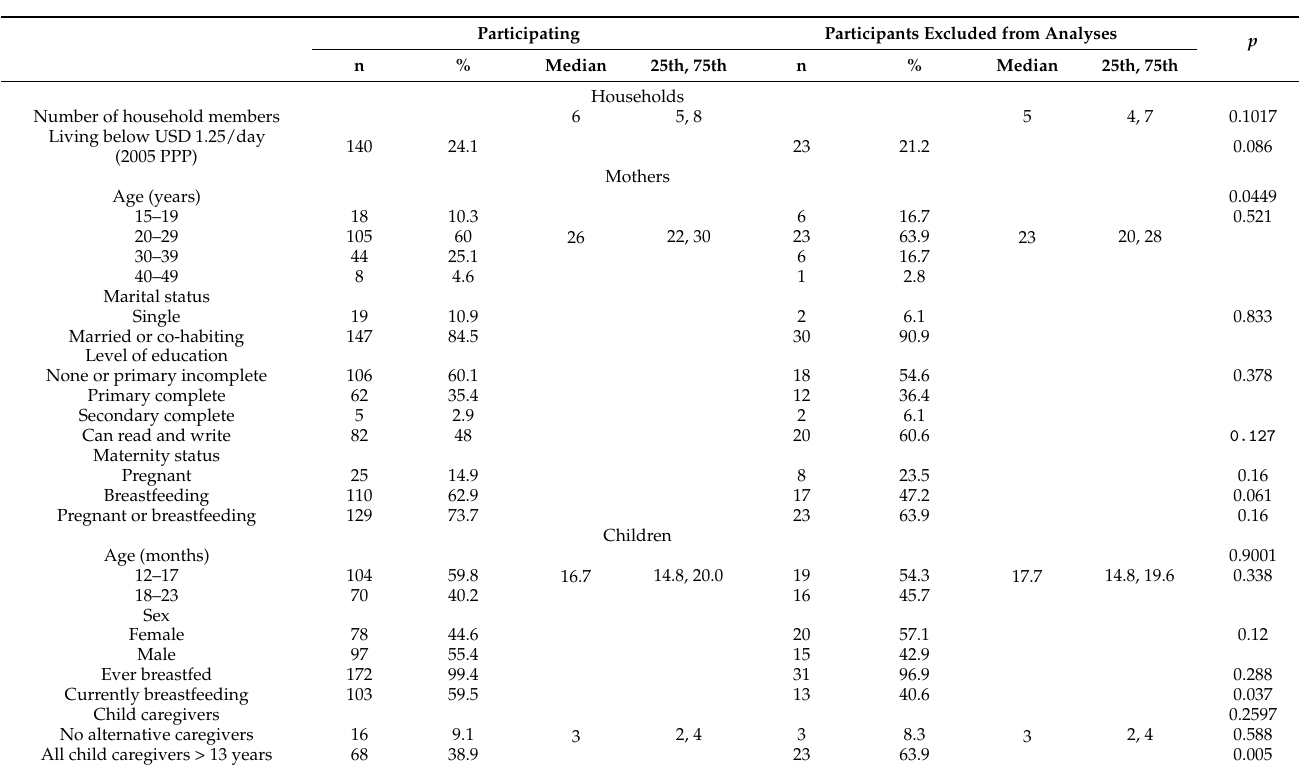
Table 1. Characteristics of households, mothers, and children participating in and excluded from the